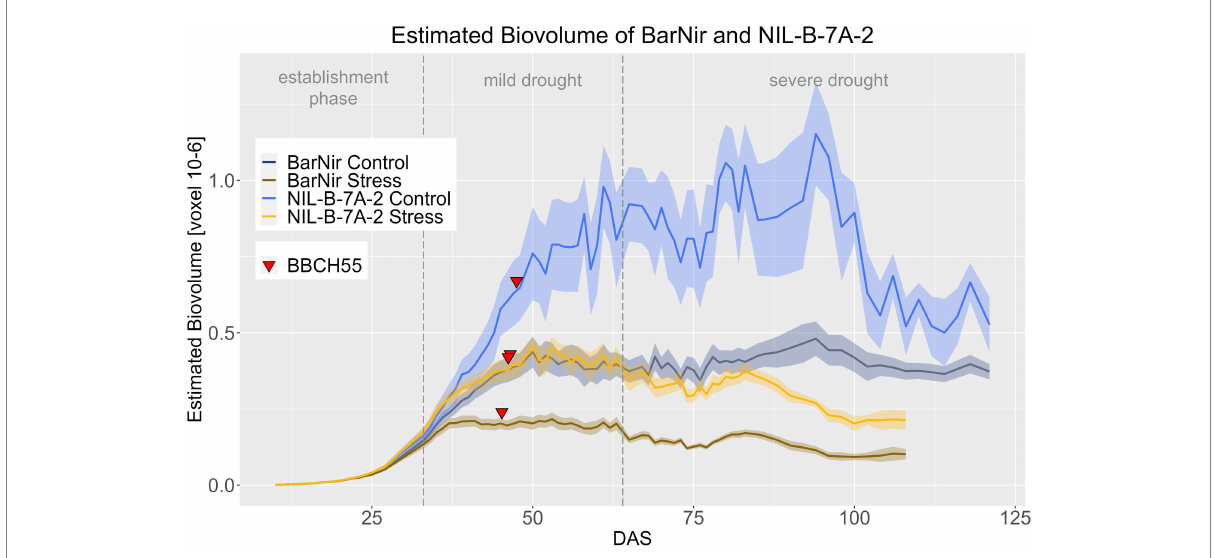
FIGURE 3 A Estimated biovolume of BarNir and NIL-B-7A-2 based on the calculated BLUEs values. DAS, days after sowing; BBCH55, heading day. The last DAS for each genotype was chosen for the DAS where the last time 60% of the plants were imaged (as mature plants were taken off subsequently). The shadows describe the confidence interval; as long as the shadows of the individual lines (parent and corresponding NIL) do not overlap, the significance level of a = 0.05 is not reached and therefore a significant difference